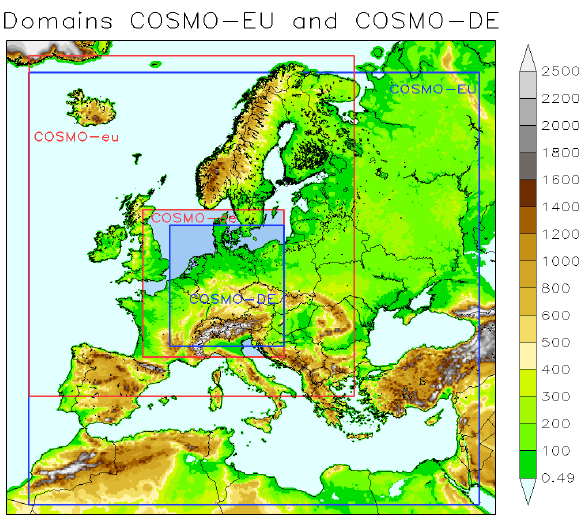
Figure 1. Domains of COSMO: the red lines show the domains of the 7km COSMO-eu, and 2.2km COSMO-de. The blue lines show the domains of the operational versions COSMO-EU and COSMO-